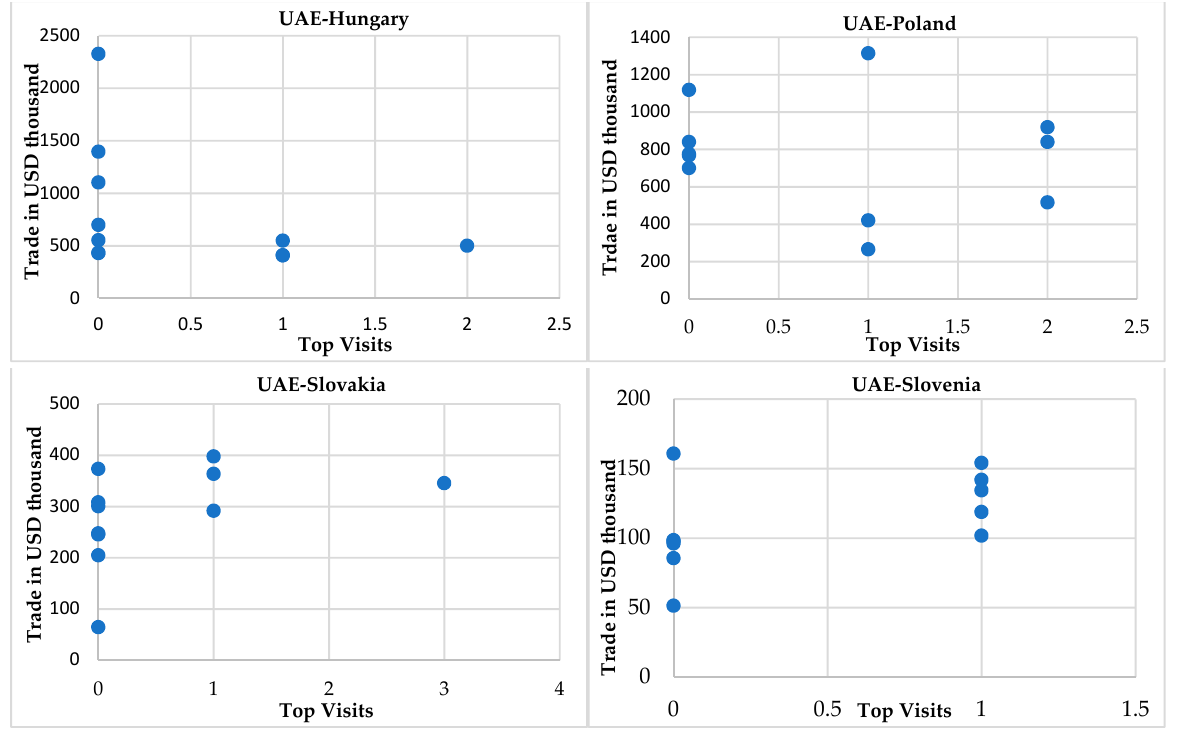
Figure 5. A correlation between top visits and trade.